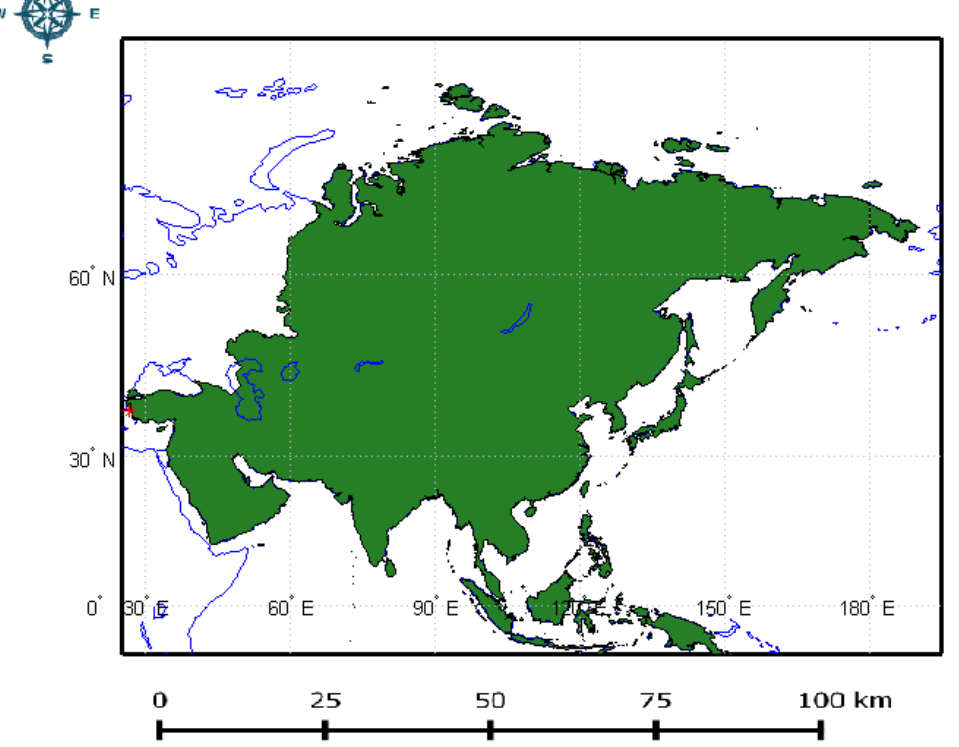
Figure 1. Area of study. The location in green represents the Asian continent; the red dot is the Asia location in Turkey where T . absoluta was discovered for the first time in 2009. This point is also the initial location for the model simulation.